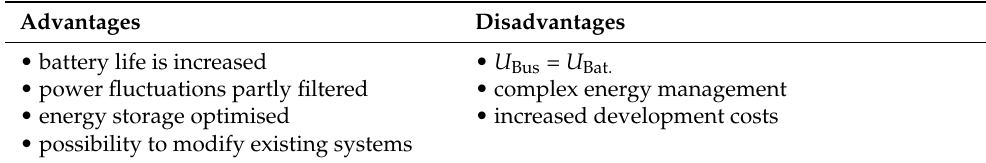
Table 12. Advantage and disadvantages Topology